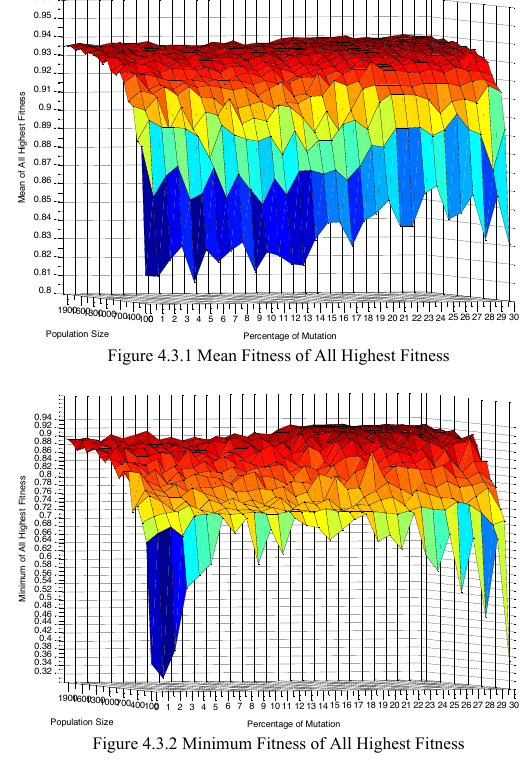
Figure 4.2.2 Minimum Fitness of All Highest Fitness